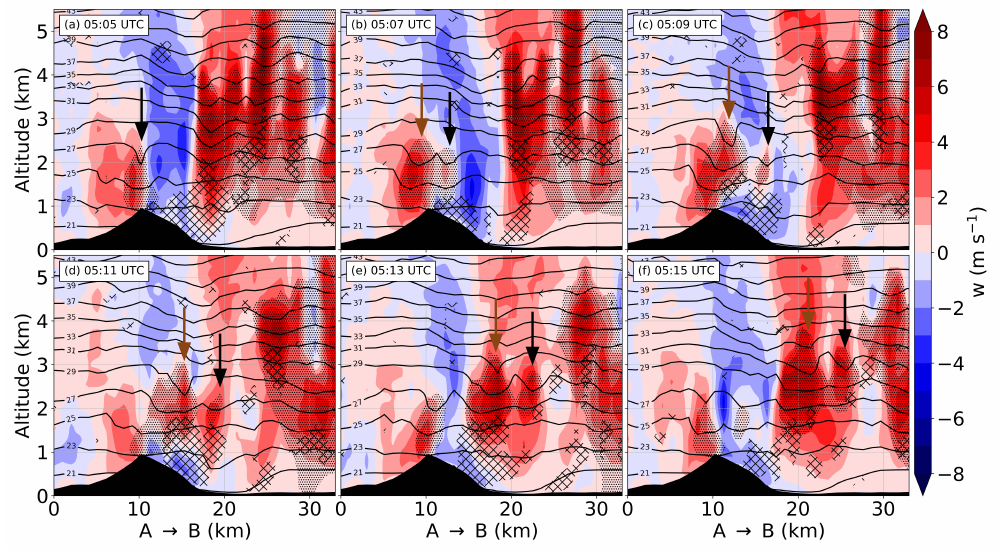
Figure 15. Vertical velocity ( w ; ms − 1 ), potential temperature (black contours; ◦ C), horizontal convergence > 2 × 10 − 3 s − 1 (black diagonal hatches) and hydrometeor mixing ratio > 1gkg − 1 (little black dots) between 05:05 and 05:15UTC on 15 October. Terrain is in